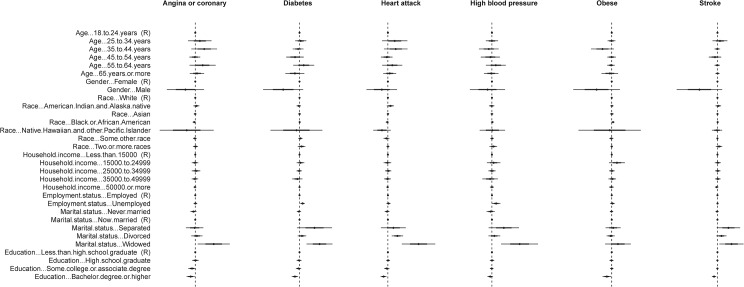
Coefficients of independent demographical variables in models predicting different NCD and risk factors.The dashed lines show the zeros. The center dots show the means of coefficients. The thicker bars show ± sd and the thinner bars show ± 2sd based on 1000 models with resampling of the training data.